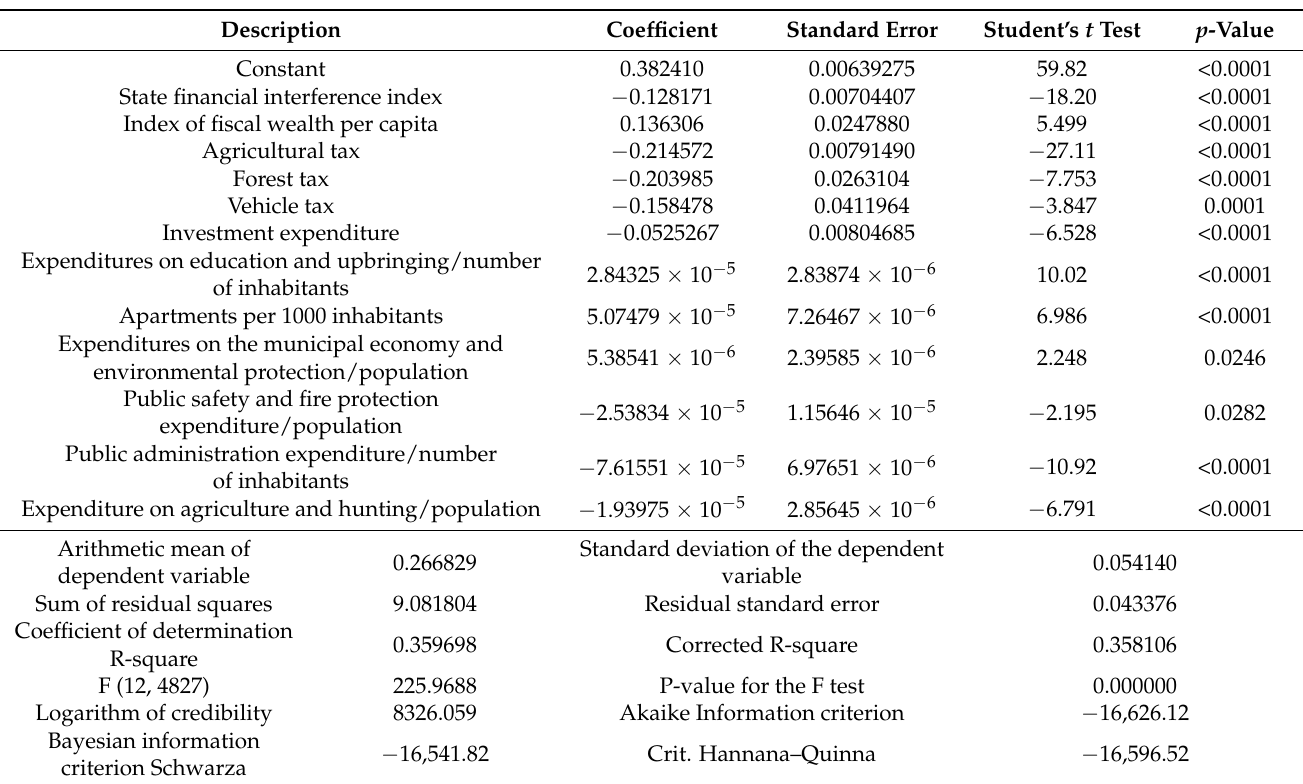
Table 6. Results of the regression analysis between the financial situation (q) and the variables of development of rural communes in eastern